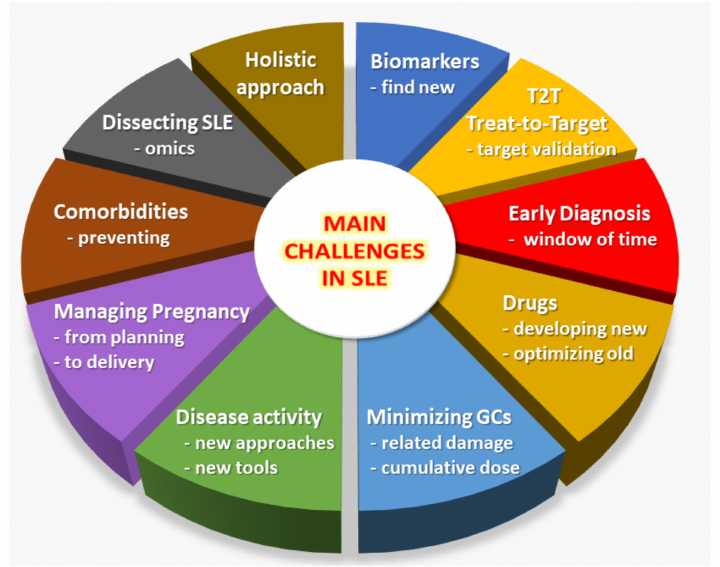
Figure 1. Overview of the main unmet needs in the field of Systemic Lupus Erythematosus